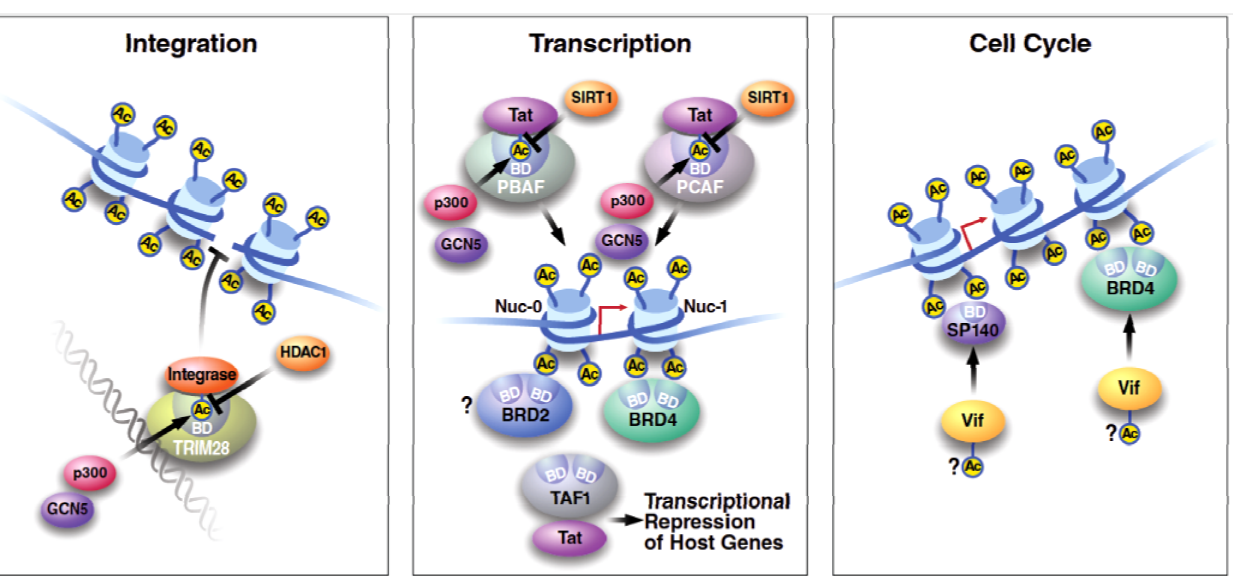
Figure 2. Role of bromodomain proteins in HIV infection. Bromodomain proteins implicated in HIV transcription, HIV integration, and cell cycle progression are schematized. Briefly, acetylated integrase displays enhanced enzymatic activity, yet generates an interaction interface for the TRIM28 bromodomain that in turn recruits the HDAC1 deacetylase, negatively impacting HIV integration. With respect to viral transcription, Tat acetylated at K50/51 interacts with BAF180 and Brg-1 within the PBAF complex to support viral transcription. Acetylated Tat also interacts with